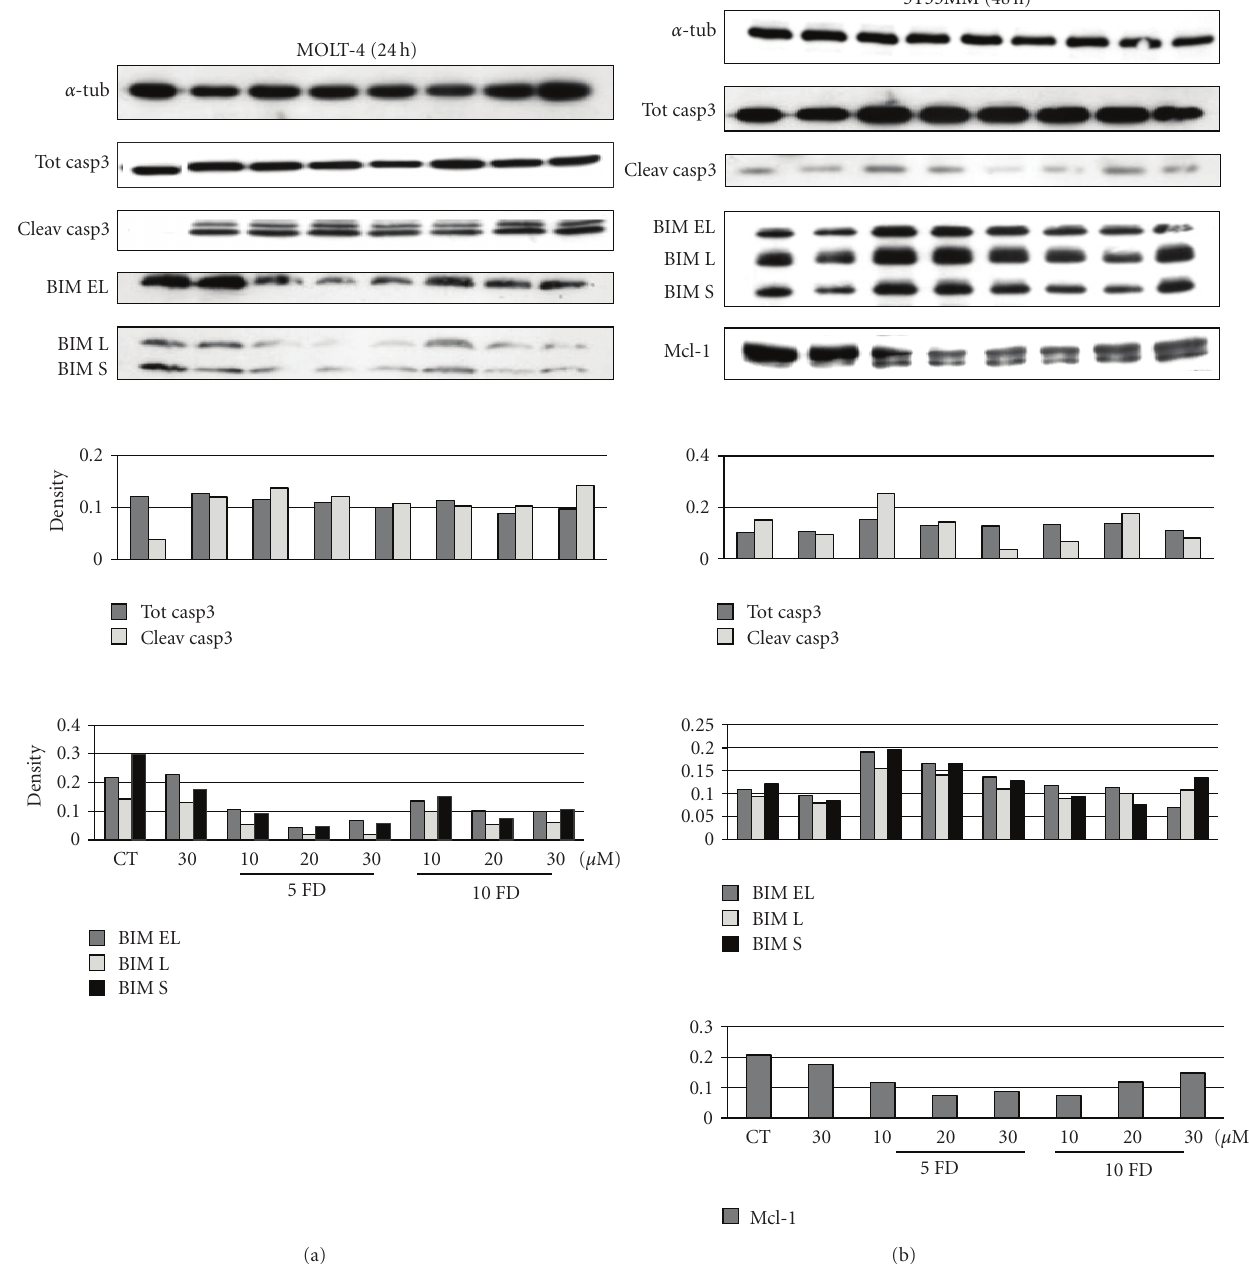
Figure 6: Expression of apoptosis molecules. The e ff ect of di ff erent concentrations of forodesine and dGuo on the expression of caspase 3 cleavage, BIM and Mcl-1 are shown in MOLT-4 (a) and 5T33MM (b) cells. β -actin was used as loading control, one experiment representing 3 is